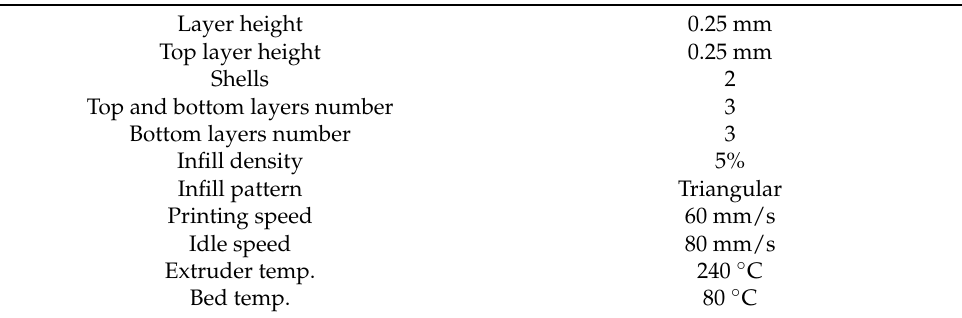
Table 1. Process parameters for sample